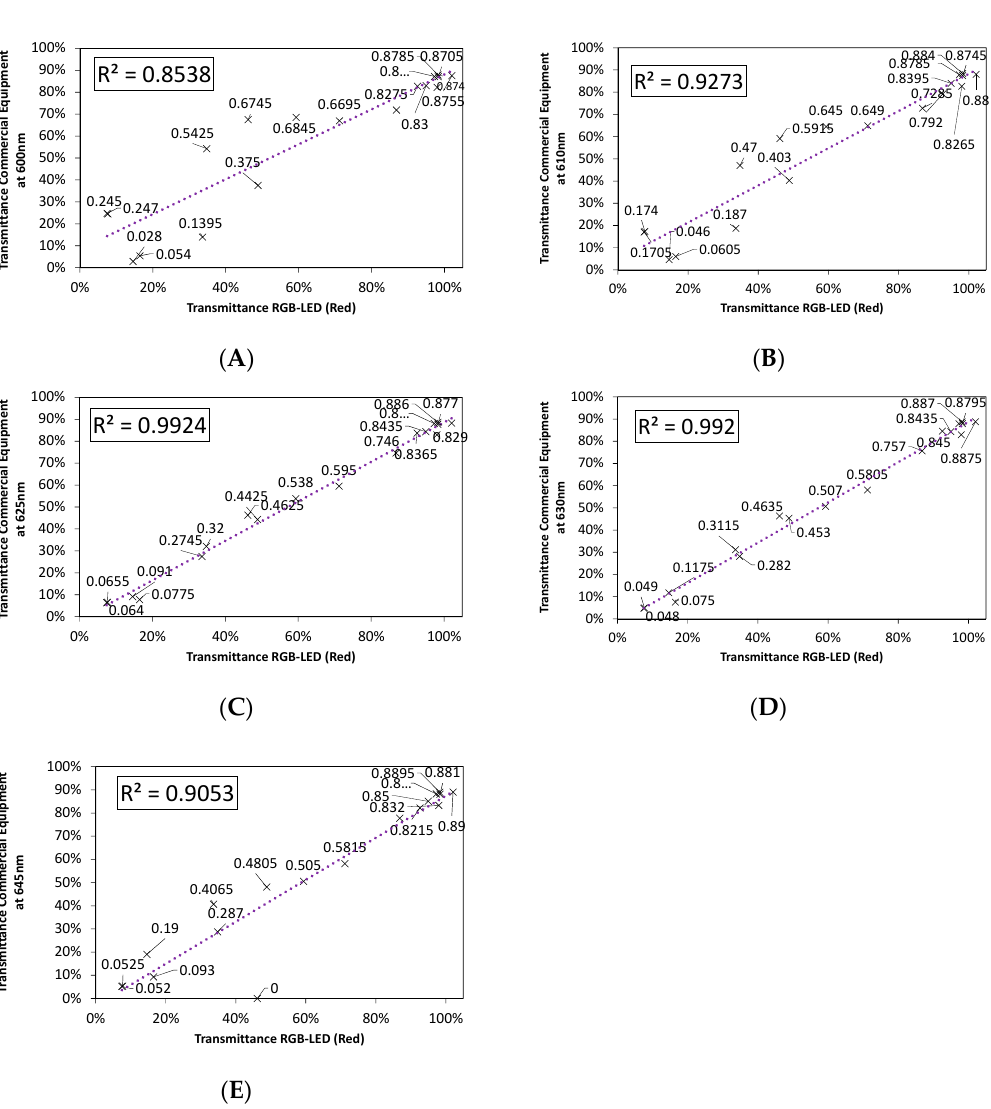
Figure 8. Comparison of the fit for the emission spectrum of the red LED to: ( A ) 600 nm, ( B ) 610, ( C ) 625 nm- λ Peak, ( D ) 630 nm, and ( E ) 645 nm.